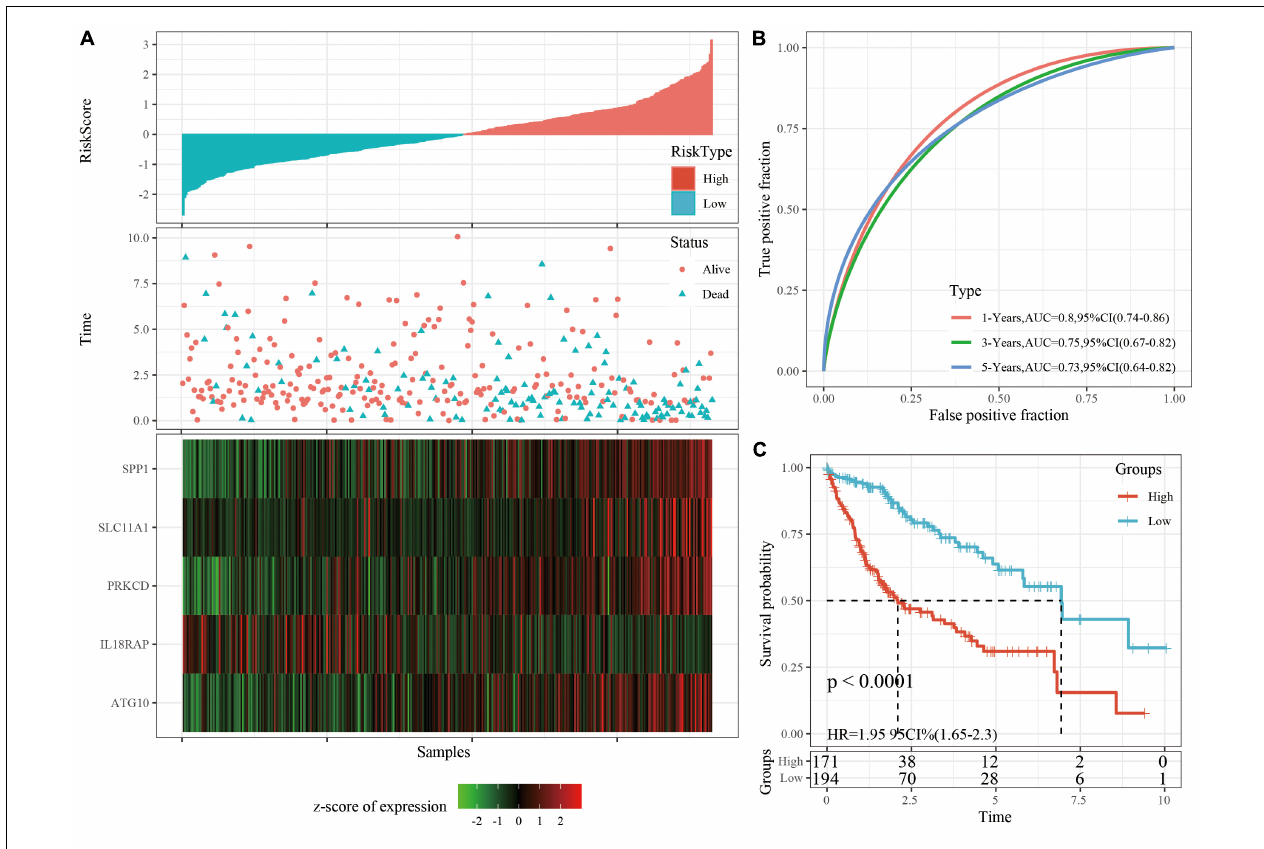
FIGURE 5 | (A) RiskScore, survival time, survival status, and 5-gene expression in TCGA data sets. (B) ROC curve and AUC of 5-gene signature classification. (C) The KM survival curve distribution of 5-gene signature in TCGA data